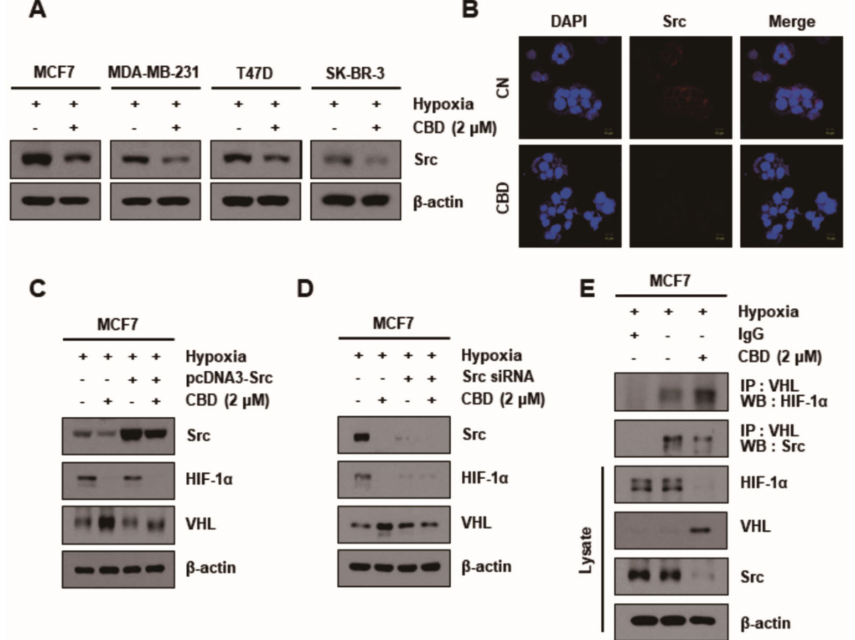
Figure 3. Src regulates the HIF-1 α expression via ubiquitination of VHL. ( A ) MCF7 cells were treated with or without CBD (2 µ M) in hypoxia conditions. The expression level of Src detected by Western blotting. β -actin was used as a loading control. ( B ) Immunofluorescence images showed the expression of Src in MCF7 cell lines. ( C ) MCF7 cells were transiently transfected with pcDNA3-Src plasmid or ( D ) Src siRNA and then treated in both groups under hypoxia. The cells were then lysed, and Western blotting was performed for Src, HIF-1 α , VHL, and β -actin. β -actin was used as a loading control. ( E ) The interaction between VHL and HIF-1 α or Src was assessed by co- immunoprecipitation assay. Cells were treated with CBD (2 µ M) in hypoxia conditions. Cell lysates were immunoprecipitated with the IgG and anti-VHL antibody, followed by immunoblotting for HIF-1 α , Src, total HIF-1 α , VHL, and β -actin. β -actin was used as a loading control. CBD;